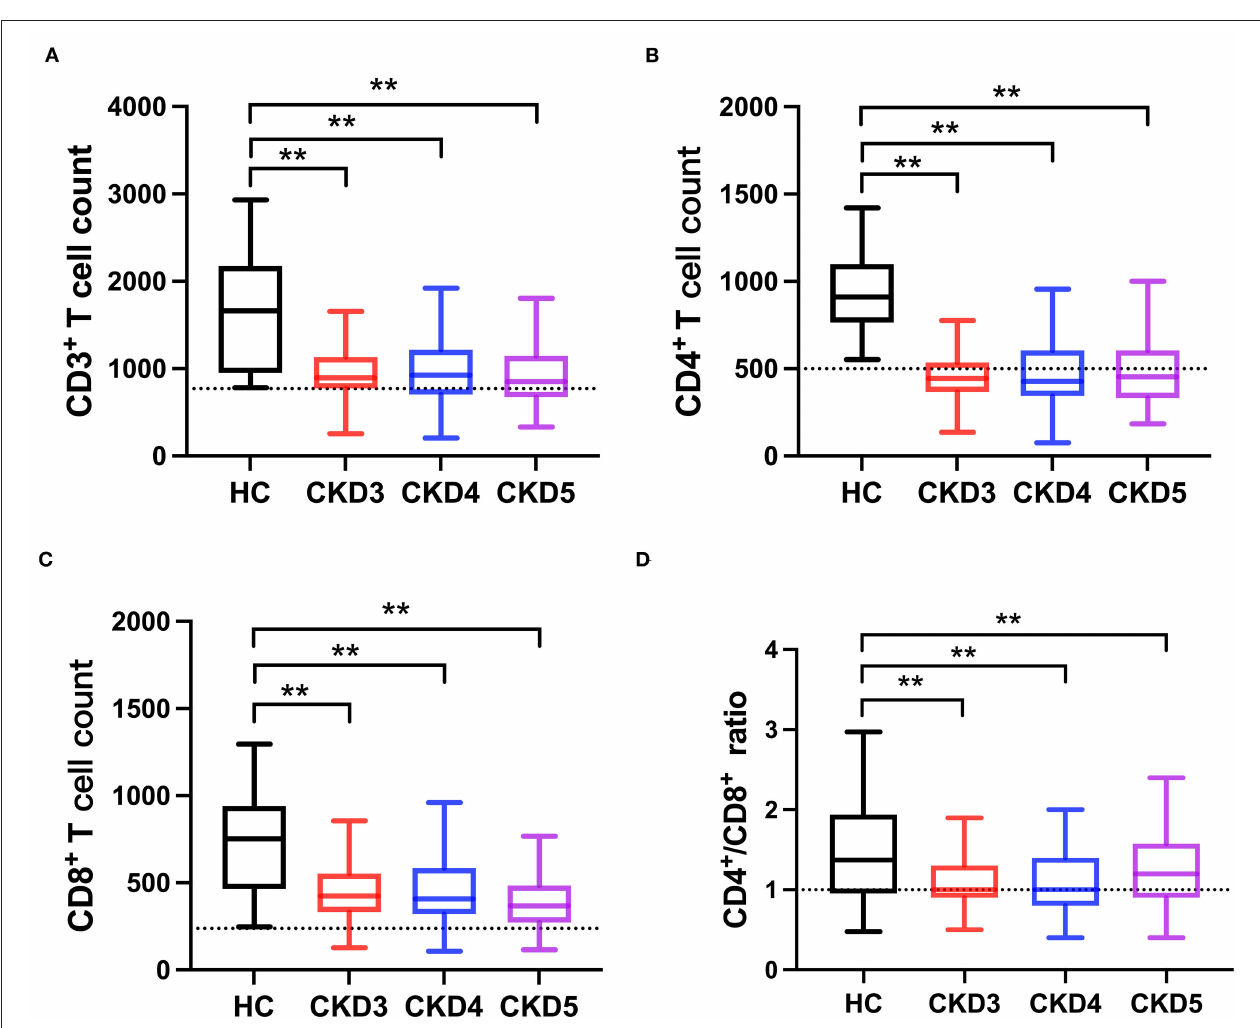
FIGURE 1 | Comparison of T-lymphocyte subsets between CKD patients and healthy subjects (HC). (A) CD3 + T cell count, (B) CD4 + T cell count, (C) CD8 + T cell count, (D) CD4 + /CD8 + T cell ratio. The dotted line represented the normal value. ** p < 0.01.